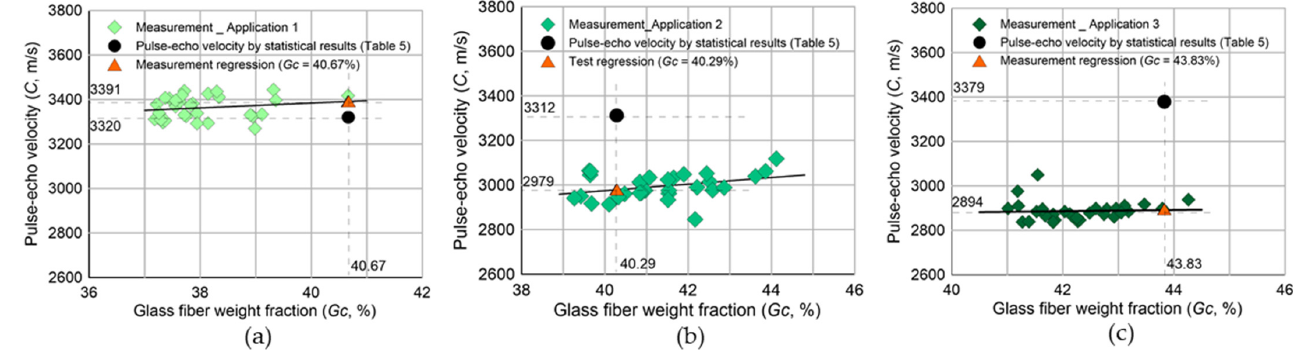
Figure 5. Comparison of ultrasonic pulse-echo velocity for Application ( a ) 1, ( b ) 2, and ( c ) 3.